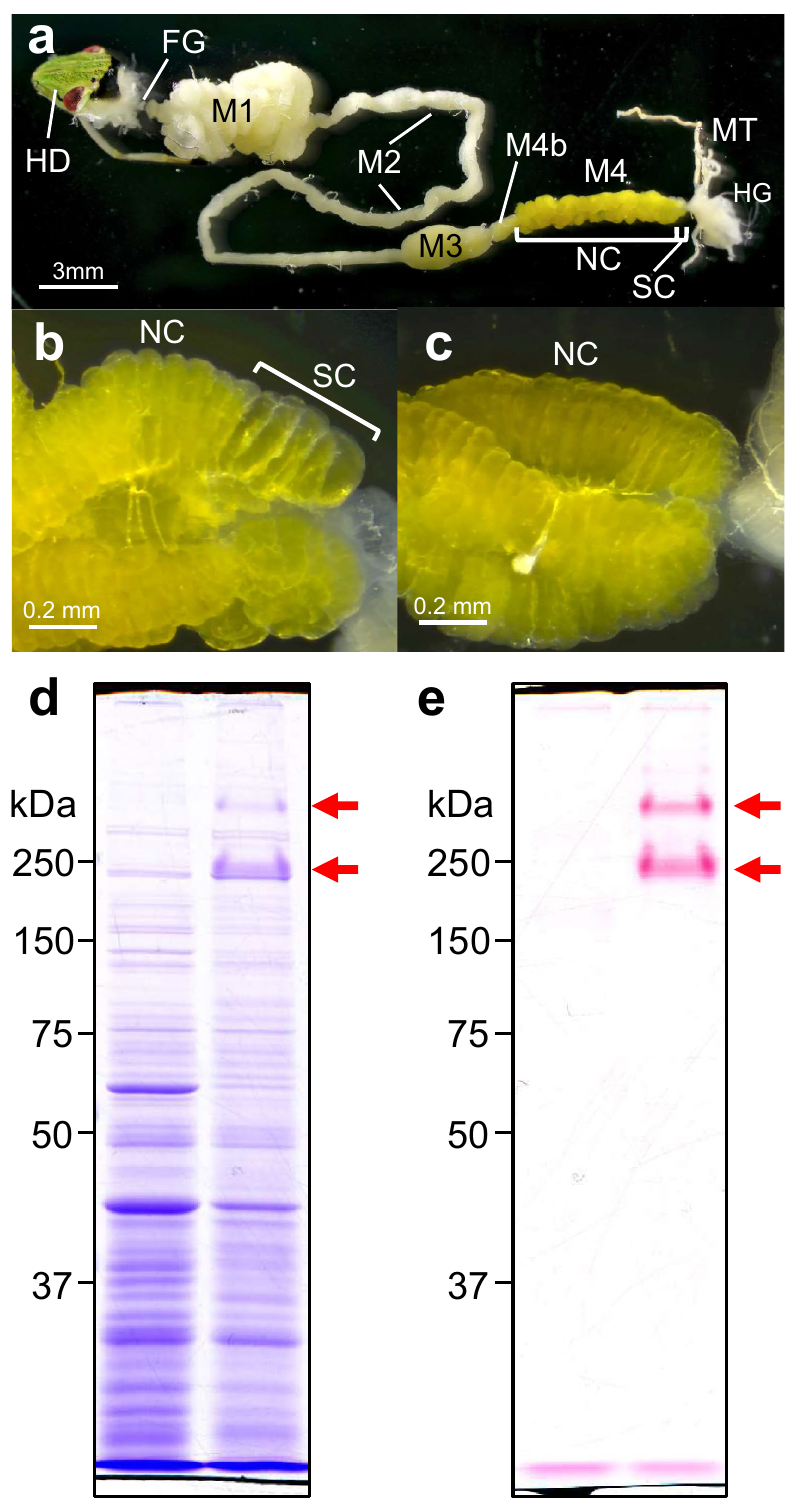
Figure 1. Detection of proteins specifically expressed in the female-specific swollen crypts of the symbiotic midgut. ( a ) An alimentary tract dissected from an adult female. The symbiotic midgut M4 region consists of a long stretch with normal crypts and a posteriormost short region with swollen crypts. ( b ) The posterior end of the midgut M4 region of an adult female with swollen crypts. ( c ) The same region of an adult male without swollen crypts. HD, head; FG, foregut; M1, M2 and M3, midgut M1, M2 and M3 regions; M4b, bulb-like midgut region anterior to M4; M4, symbiotic midgut M4 region with crypts; NC, normal crypt; SC, swollen crypt; HG, hindgut; MT, Malpighian tubule. ( d , e ) Proteins of normal crypts and swollen crypts were separated on SDS-PAGE gels and visualized by CBB staining for whole proteins ( d ) and PAS staining for glycosylated proteins ( e ). Arrows show the prominent protein bands specifically detected from the swollen